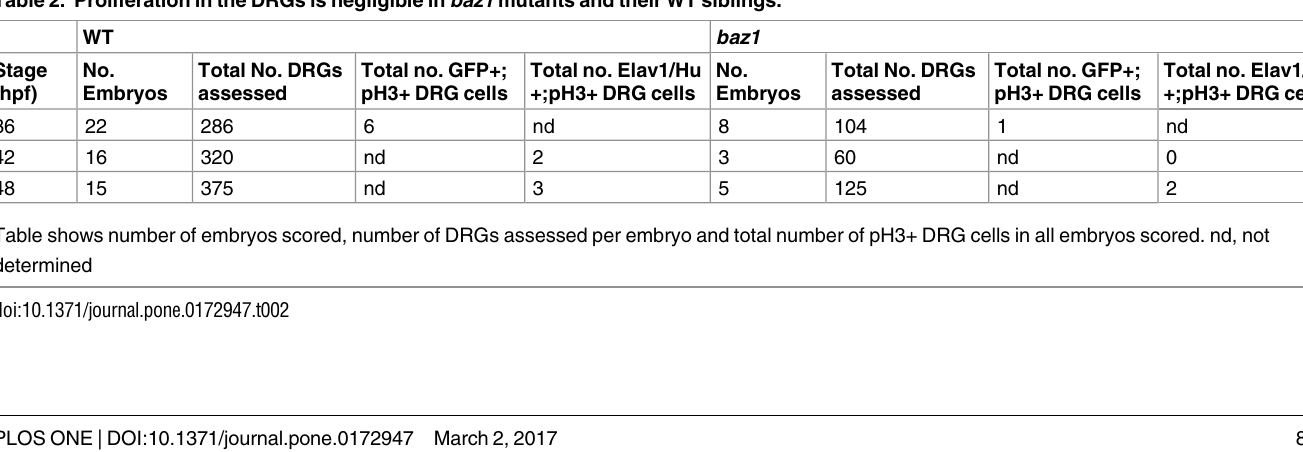
much reduced numbers of peripheral glial cells and no sign of Schwann cell differentiation.